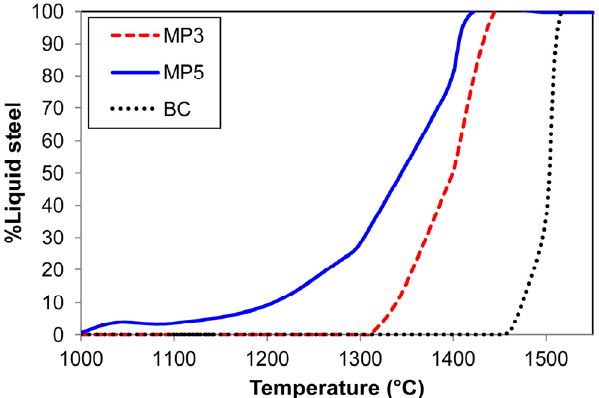
Figure 11. Solidification curves for BC, MP3, and MP5 weld metal compositions calculated in FactSage 7.3